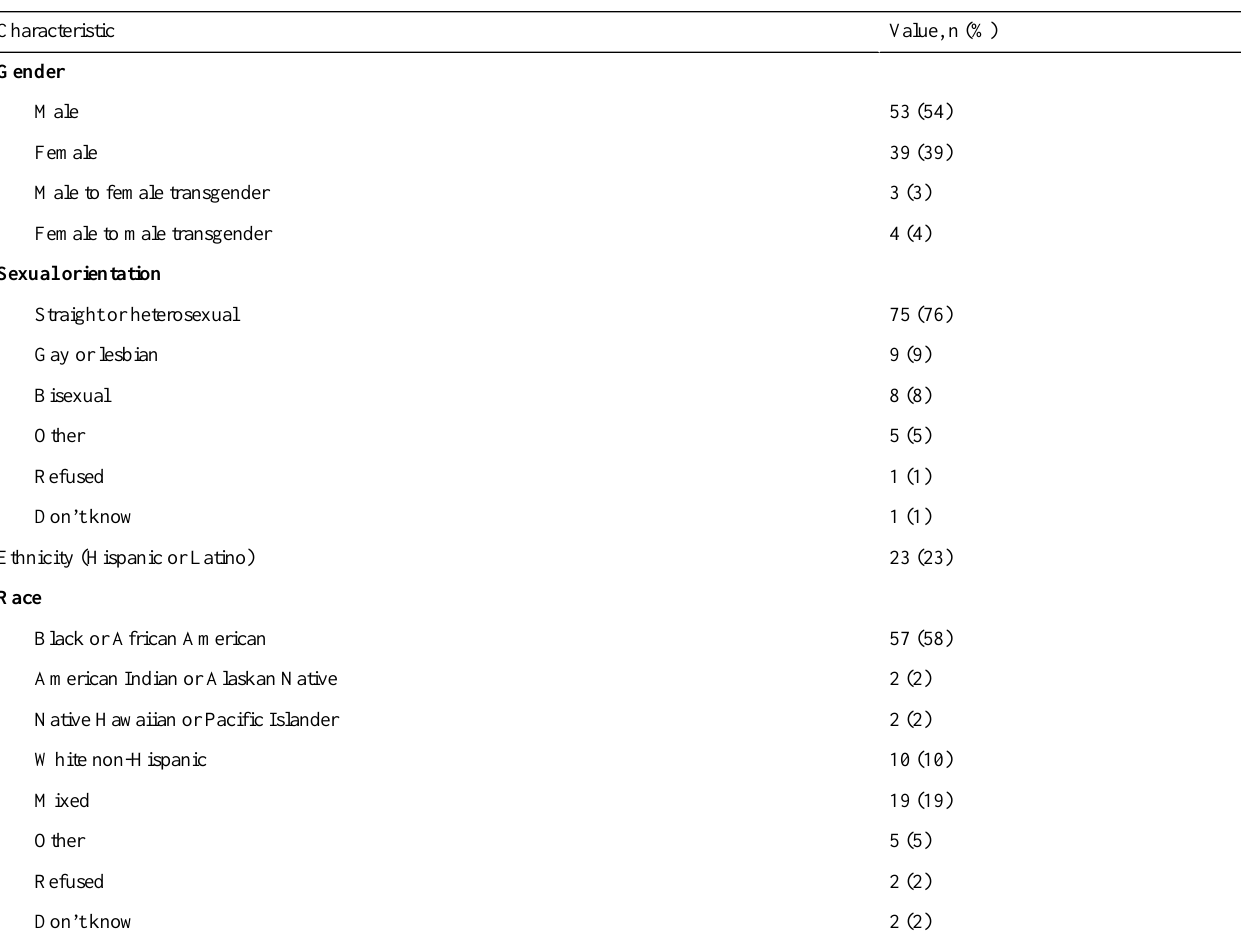
Table 2. Demographic characteristics of an urban sample of unstably housed youth